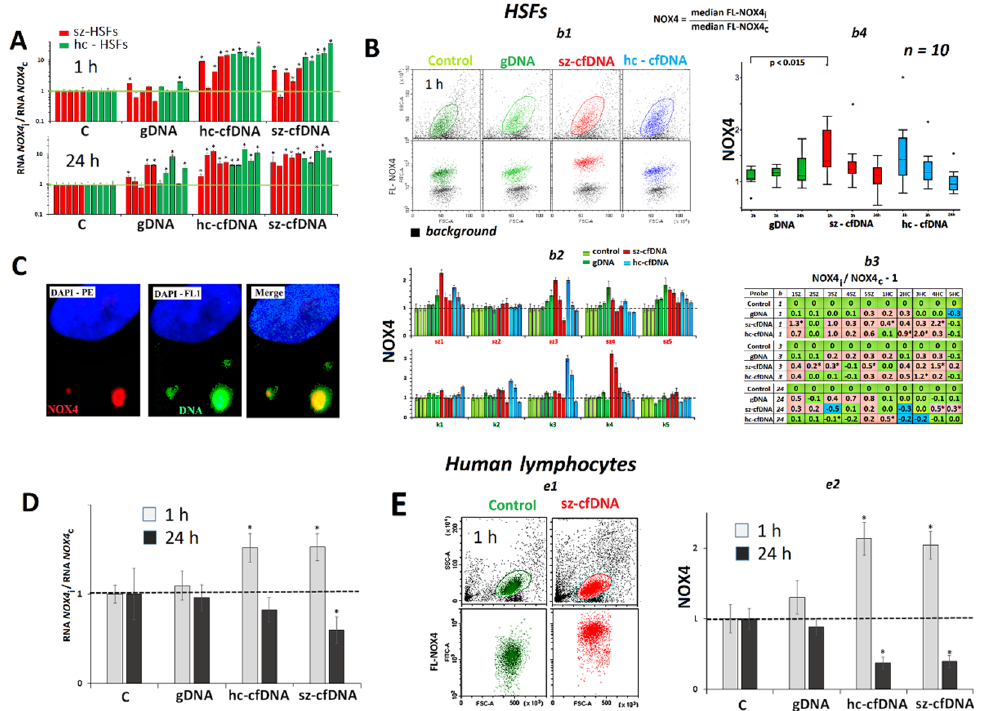
Figure 2. The exposure of HSFs and PBL to cfDNA (50 ng/mL) leads to the changes in NOX4 expression. ( A ). Change of the RNA NOX4 in HSFs in the presence of DNA samples. Average values for three measurements and standard deviation are given. The cultivation time and the DNA samples are indicated on the graph. The response to cfDNA differs from the control HSFs ( p < 0.01). ( B ). b1 —The most typical examples of NOX4 assay with FCA in HSFs. The data from the device are given for sz-HSF3 (1 h). b2 —Index NOX4: the values of the medians of FL-NOX4i, normalized